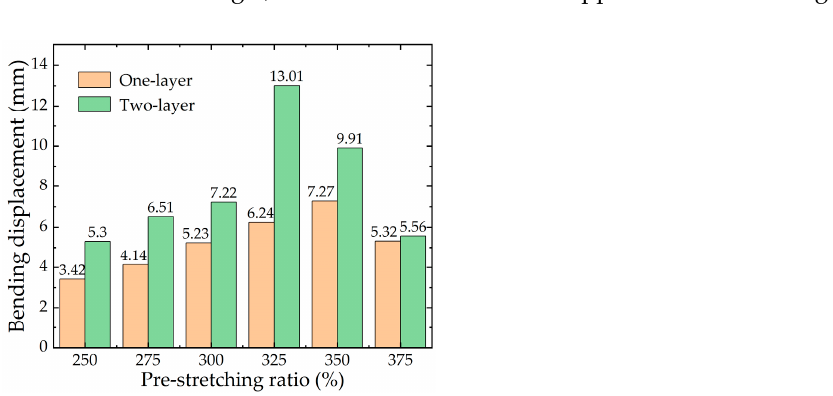
Figure 7. Simulation results with different layers and pre-stretching ratios of the DE membrane.